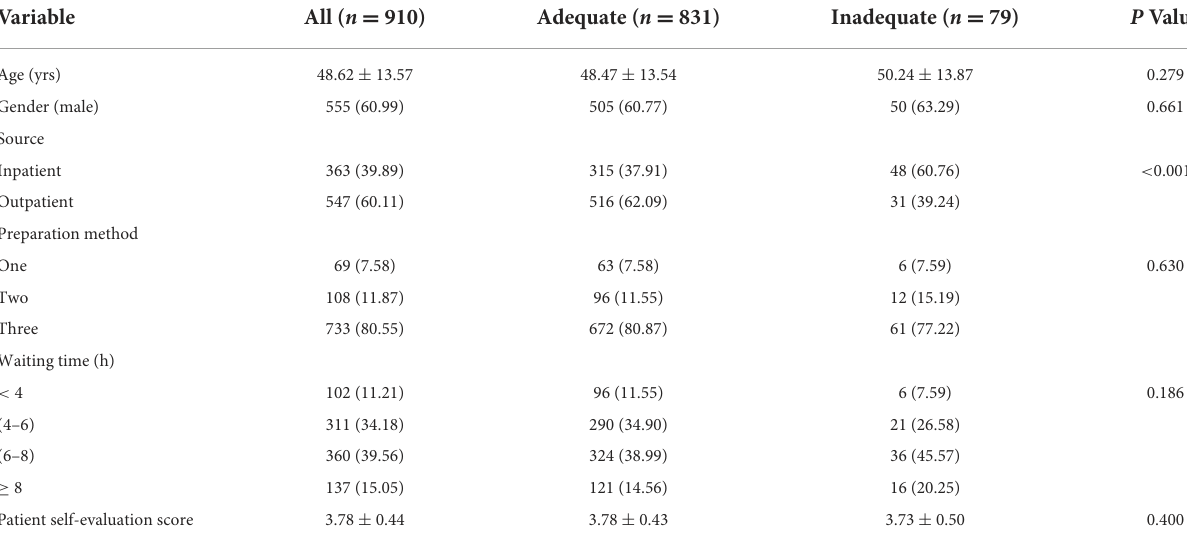
TABLE 1 Baseline characteristics of the OBPS.